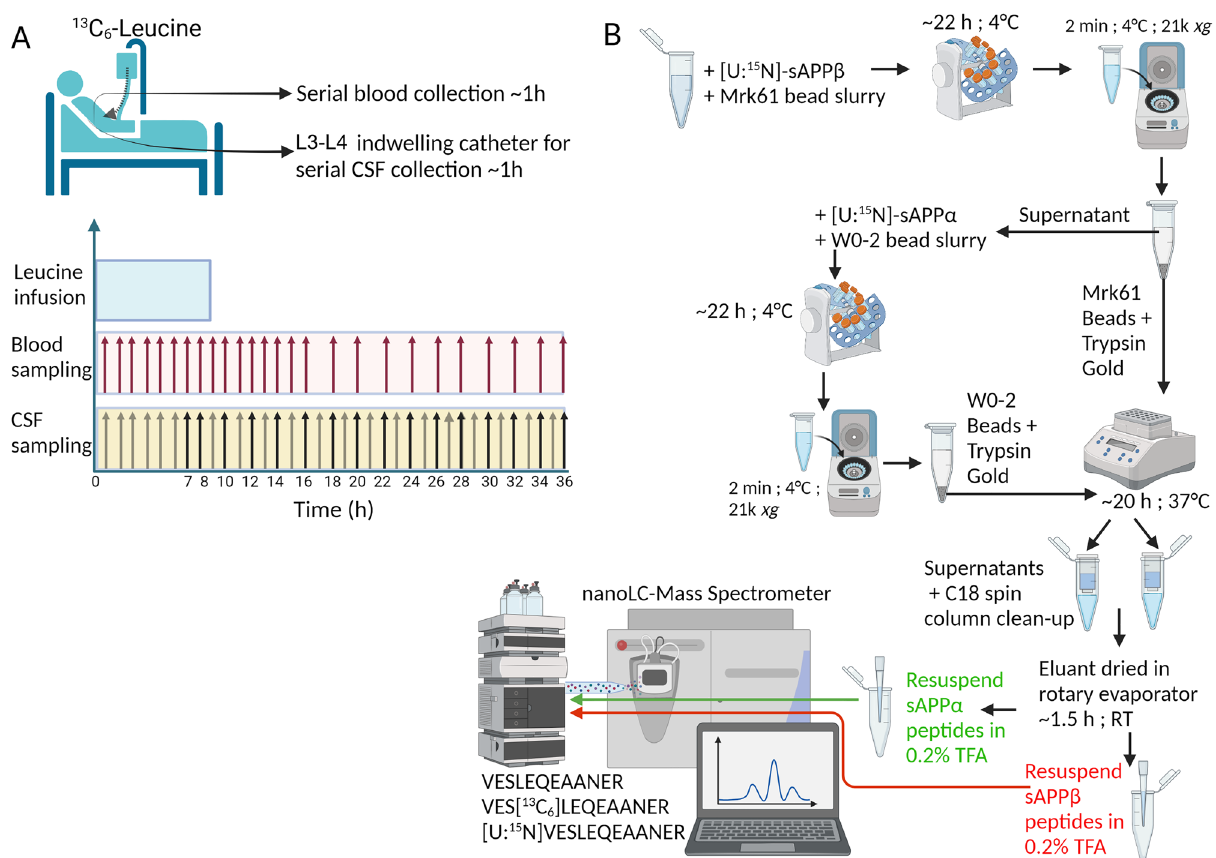
Figure 1. Experimental design. ( A ) Study participants receive a 13 C 6 -Leucine infusion for ~ 9 h starting from hour 0. CSF is collected hourly from hour 0 via an indwelling catheter placed in the L3–L4 or L4–L5 region. Black arrows indicate the hours from which the collected CSF is used for the current study. Blood is collected hourly for 16 h, and thereafter every 2 h. ( B ) CSF samples undergo a serial immunoprecipitation. Main steps are outlined: initially [U: 15 N]-sAPPβ internal standard is spiked into CSF followed by Mrk61-antibody bound Sepharose beads and an overnight incubation with rotation. Supernatants are separated from the Mrk61 beads bound to sAPPβ. [U: 15 N]-sAPPα internal standard is spiked into the supernatant followed by W0-2 antibody bound Sepharose beads. These samples undergo an overnight incubation with rotation. Following both immunoprecipitations, the W0-2 beads bound to sAPPα and the Mrk61 beads bound to sAPPβ undergo